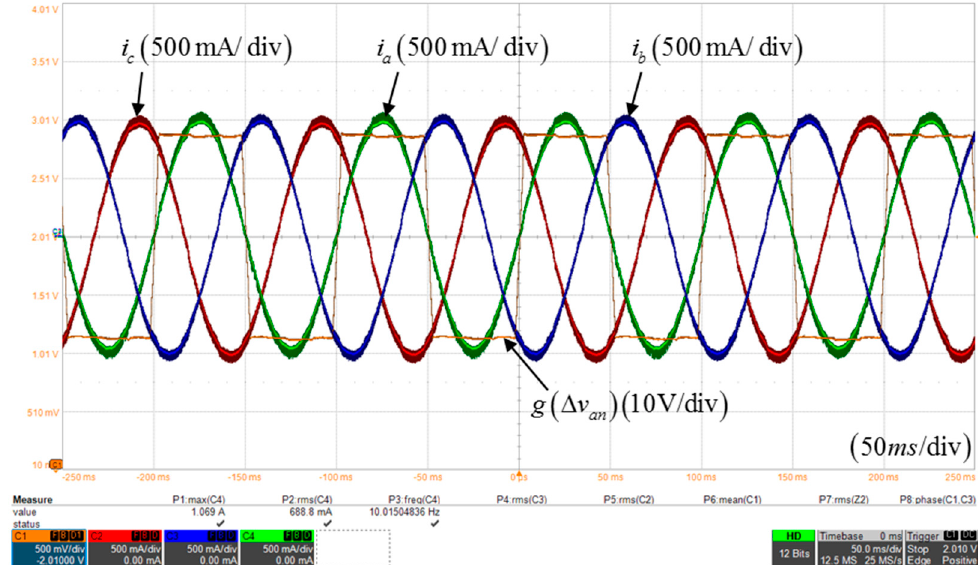
Figure 25. Three-phase currents waveforms and a-phase dead-time compensation pole voltage waveform when the proposed DTCS was applied.